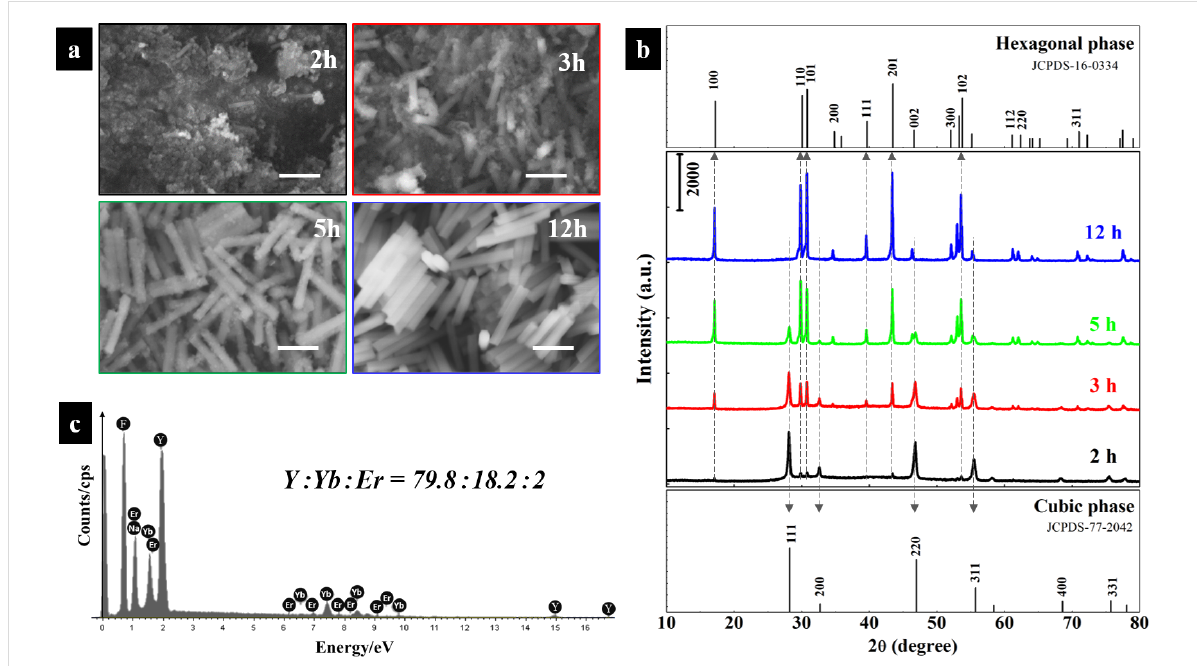
Figure 1: (a) FE-SEM morphologies of NaYF 4 :Yb 3+ /Er 3+ as a function of the reaction time (2, 3, 5 and 12 h). All scale bars are equal to 1 μ m. (b) XRD patterns of powder samples, comparing to the standard cards of hexagonal β -NaYF 4 (JCPDS-16-0334) and cubic β -NaYF 4 (JCPDS-77- 2042). (c) EDX patterns of NaYF 4 :Yb 3+ /Er 3+ as a function of the reaction time of 12 h.